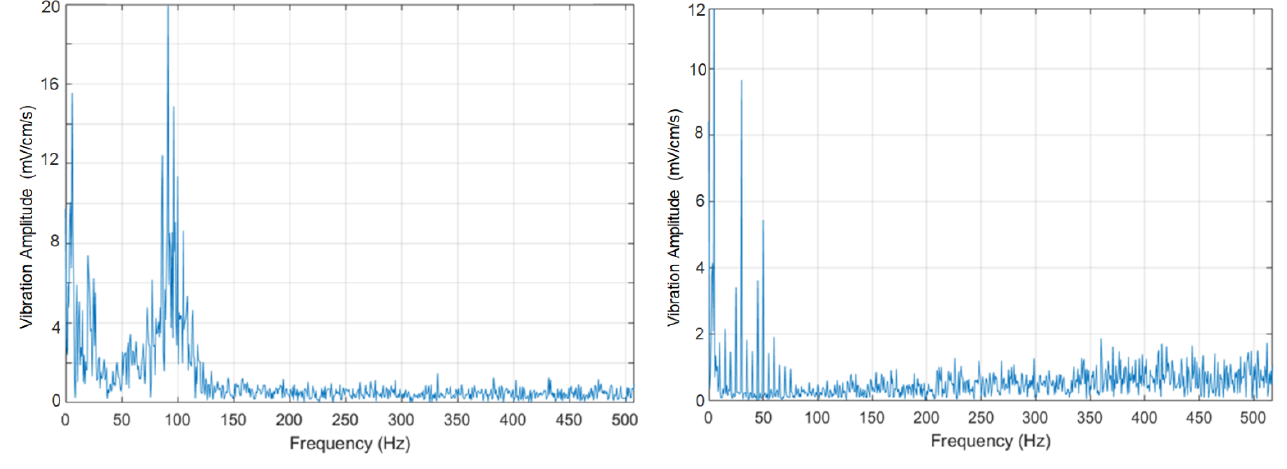
Figure 7. FFT results for the vibration velocity waveform. ( a ) FFT result for an arc fault present at 8.33 A. ( b ) FFT result for the normal state when both contacts are held firmly together. Notice that only the 50 Hz component is left, which may be caused by nearby vibrations from the power supply when there is no arc-fault state.